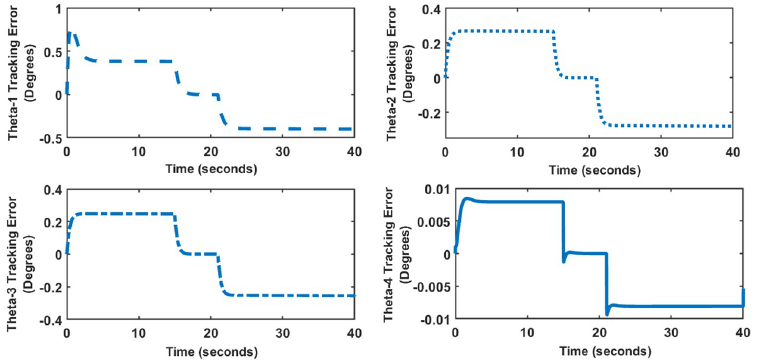
Fig 13. Tracking error for SFG-SISO PI control.